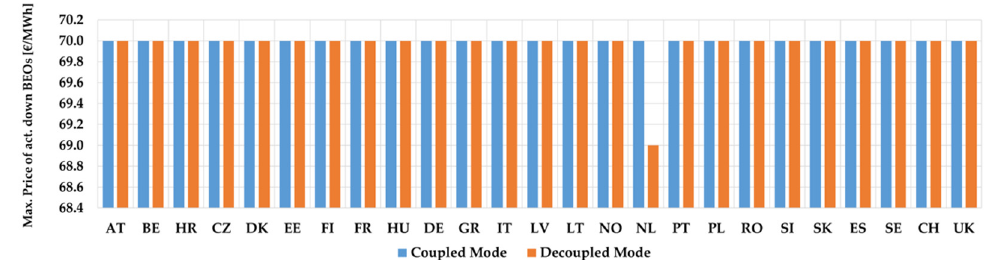
Figure 13. Maximum price of activated downward BEOs in each participating control area.